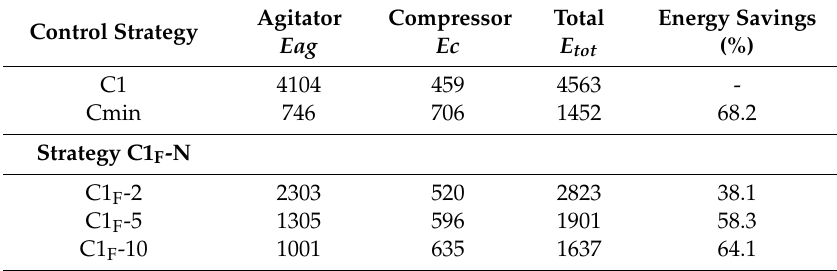
Figure 6. Control strategy C1 F -5 (with automatic detection of flooding; C OL_FLD = 1.9 mg L − 1 ): ( a ) Pag step increases; and, ( b ) C OL and vvm . Table 2. Comparison of energy requirements (MJ) for the strategies with onset of flooding detection